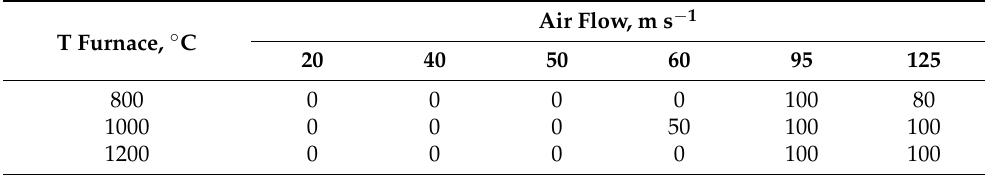
Table 1. Fragmentation event rate (%) as a function of tuyere air velocity and furnace temperature. T Furnace, °C